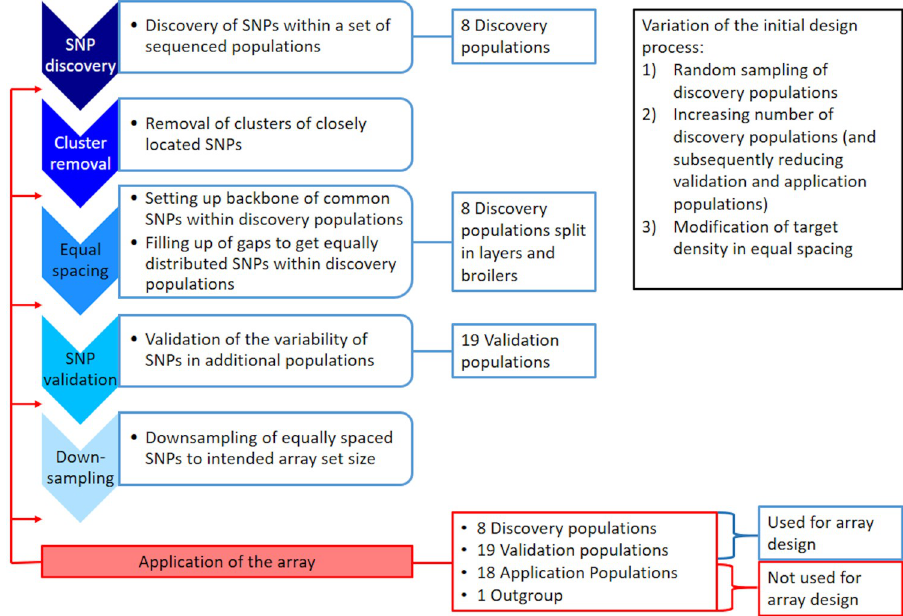
Fig 1. Flow chart of the array redesign process. The steps of redesigning the array (blue) are described in more detail in the text. Application of the array (red) was done after each subsequent step to assess the effects of the according step on the frequency